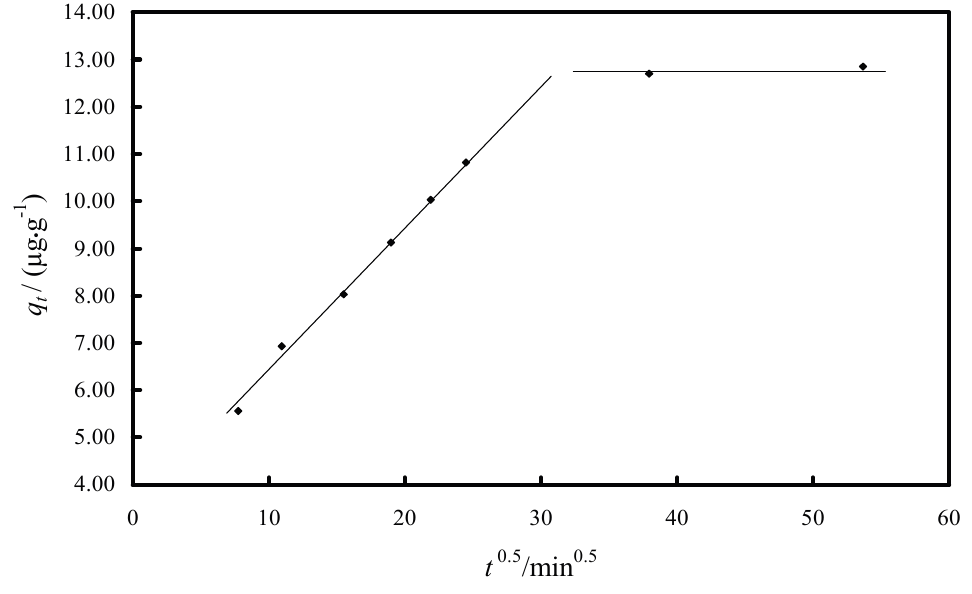
Figure 7. The Weber-Morris plot for intra-particle diffusion of the As(V) adsorption kinetic data on Fe-XAD8-DEHPA